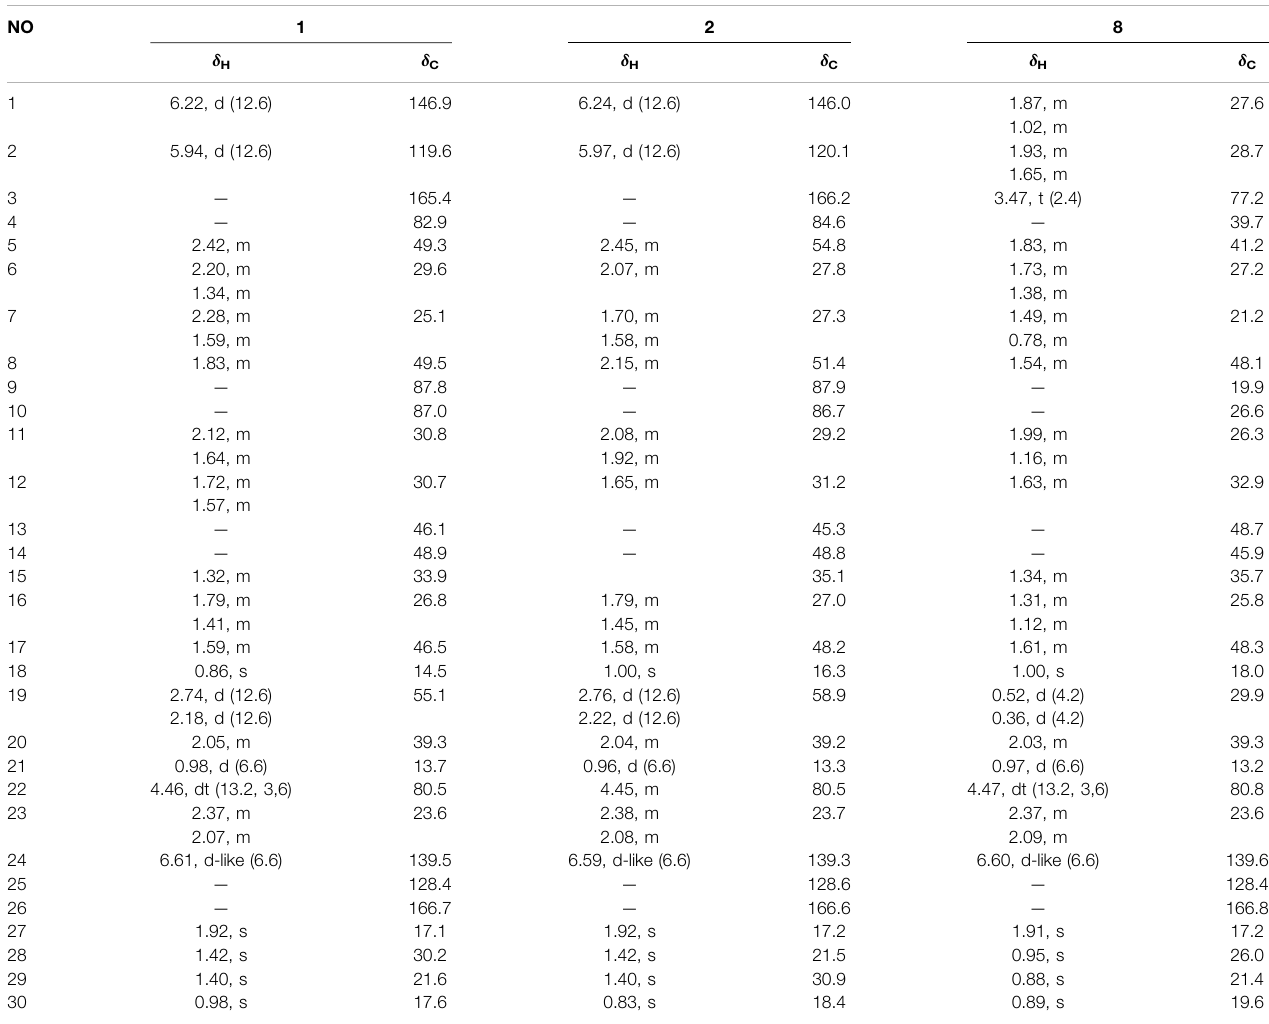
TABLE 1 | 1 H (600 MHz) and 13 C NMR (150 MHz) data of compounds 1 , 2 , and 8 in CDCl 3 ( J in Hz).